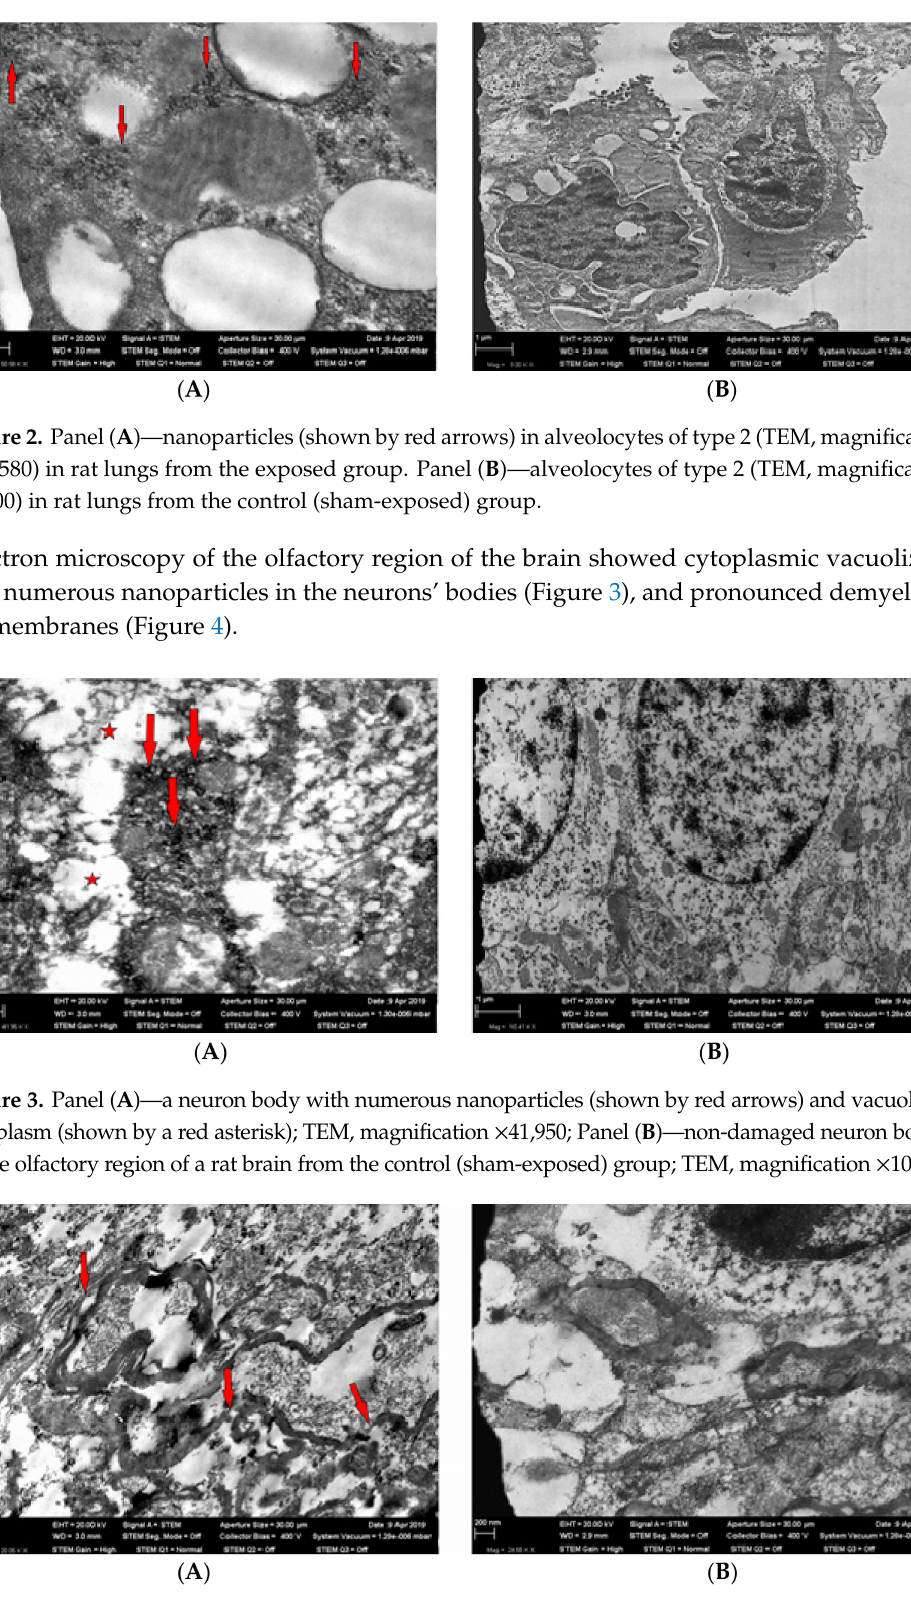
Figure 4. Panel ( A )—an axon with signs of membrane demyelinization (shown by red arrows) in the olfactory region of a rat brain from the exposed group; TEM, magnification × 20,050. Panel ( B )—non-damaged axon myelin sheath in the olfactory region of a rat brain from the control (sham-exposed) group; TEM, magnification ×